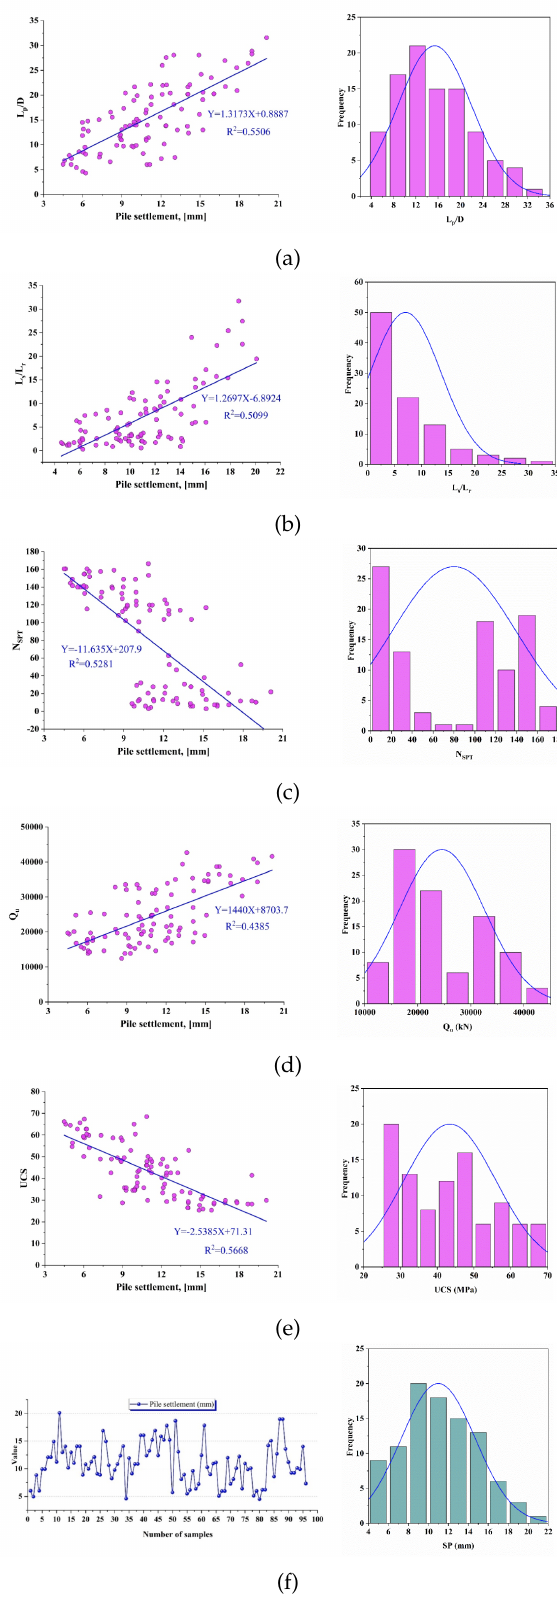
Fig. 2. The dataset distribution and their histogram